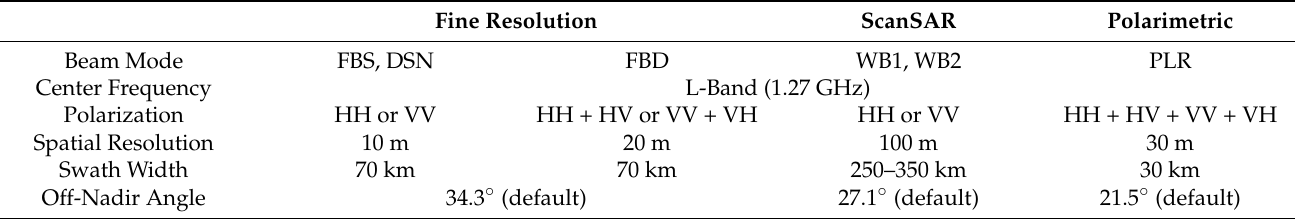
Table 2. Characteristics of the ALOS PALSAR data